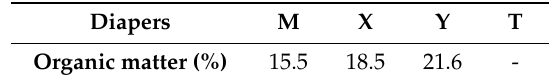
Table 1. Classification of layers according to organic matter content.